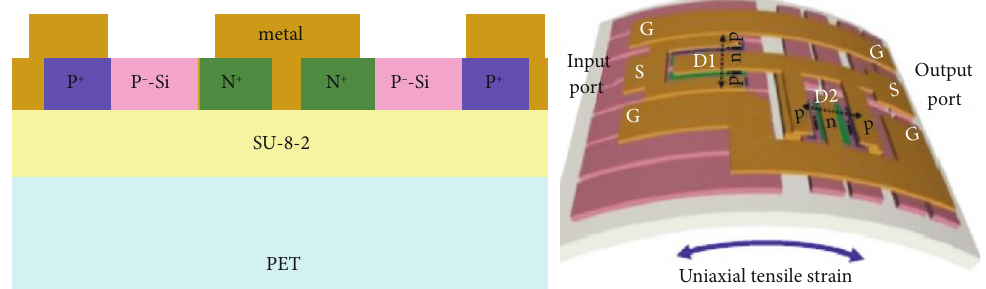
Figure 2: Schematic cross section of Si nanomembrane PIN diodes on a fl exible PET substrate [12].